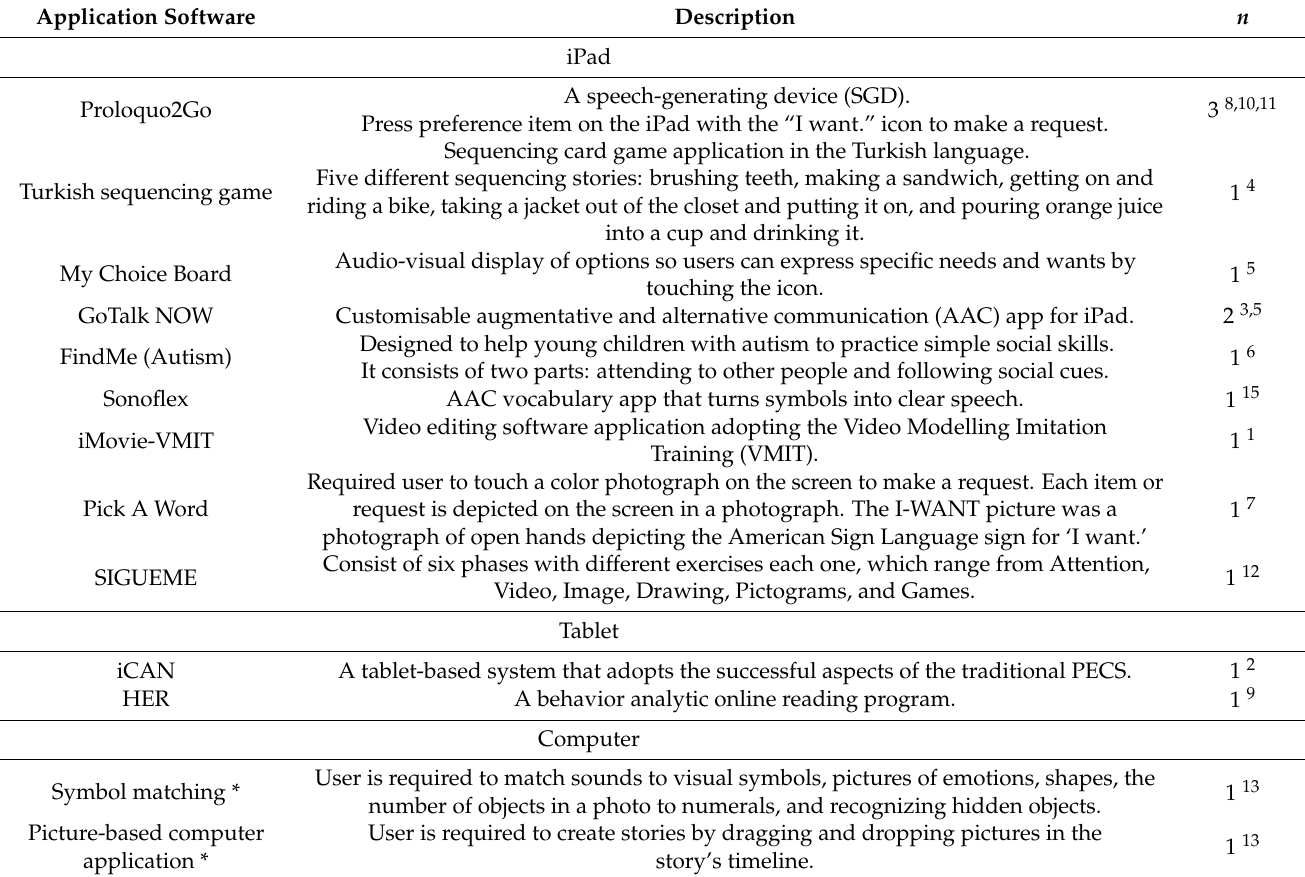
Table 2. Devices and application software used for